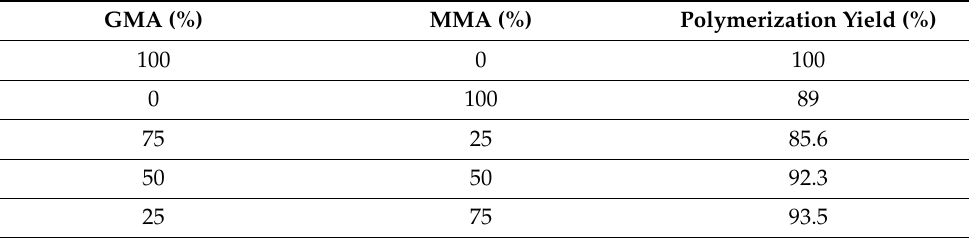
Table 1. The polymerization yield (%). GMA (%) MMA (%) Polymerization Yield